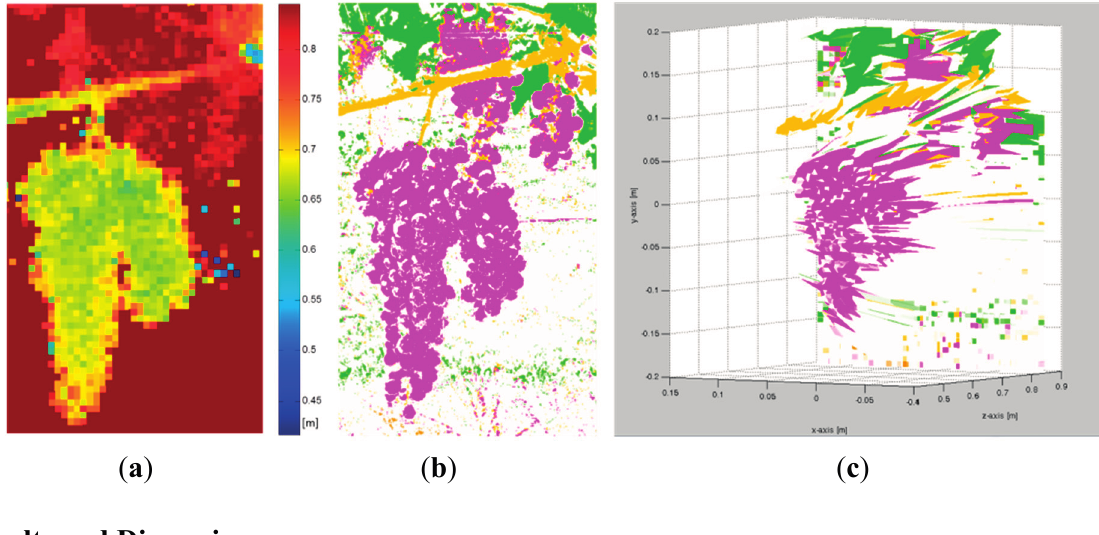
Figure 14. Close-up view of a registered region of interest. ( a ) TOF registered Z-axis range data; ( b ) Registered multispectral map; ( c ) RGB-D visualisation of the registered region of